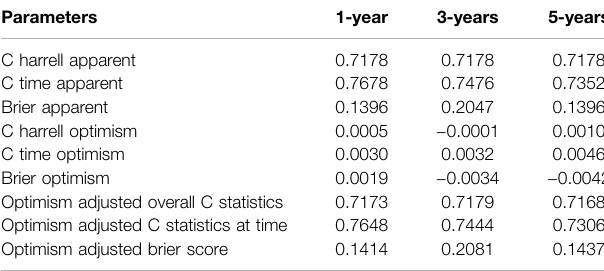
TABLE 2 | Basic parameters of enhanced bootstrap in internal